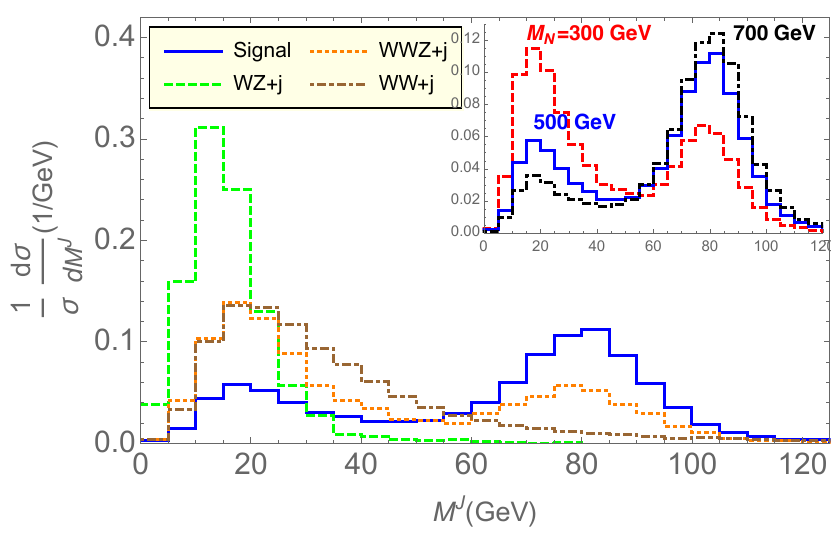
Figure 5 . Normalised di(cid:11)erential distributions as a function of fat-jet (J) invariant mass in case of same sign di-lepton + fat-jet production channel after the application of the basic selection cuts including p J > 100 GeV. Distributions of one signal region with all dominant backgrounds are T shown in the plot. Inset shows the variation for three benchmark signal points with M N = 300 ; 500 and 700 GeV.